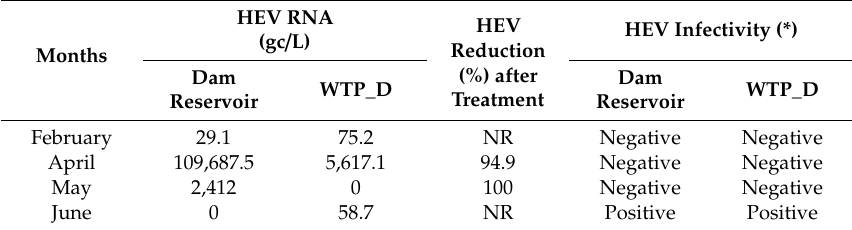
Table 4. Evaluation of related concentrated water samples (dam reservoir and WTP_D) for the presence of HEV RNA and infectious